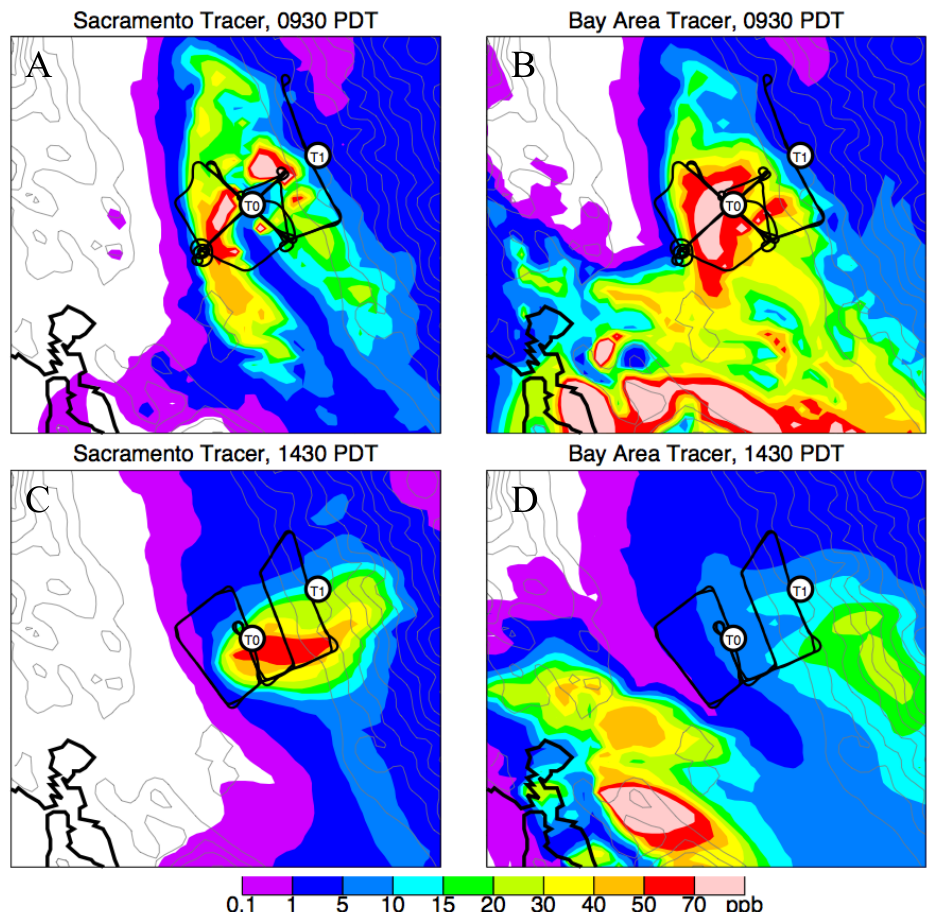
Fig. 2. WRF-Chem tracer forecasts of CO concentrations over central California on 28 June. Panels A and C show the Sacramento urban area CO forecasts at 09:30 and 14:30PDT respectively, which represent the approximate takeoff time of the morning and afternoon G-1 flights. (B) and (D) show CO forecasts at the same times for the Bay Area emissions. The color scale indicates the level of CO above the background. The solid black line is the G-1 flight path and the markers show the locations of the ground